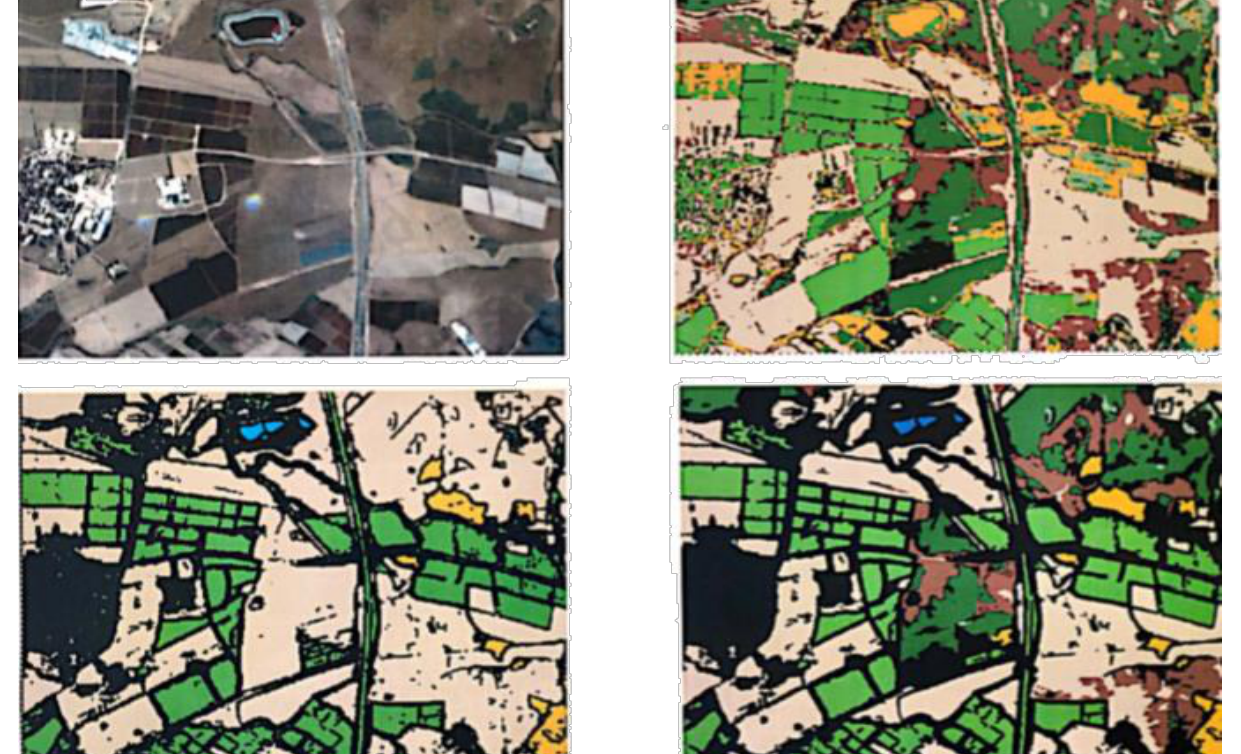
Figure 6 : Classification results for second test area. Original image (top left), edges based image classified per-object with ML classification (bottom left), ISODATA unsupervised classification for the original image (top right), final research result – edges based classified image including completion of missing areas using ISODATA (bottom